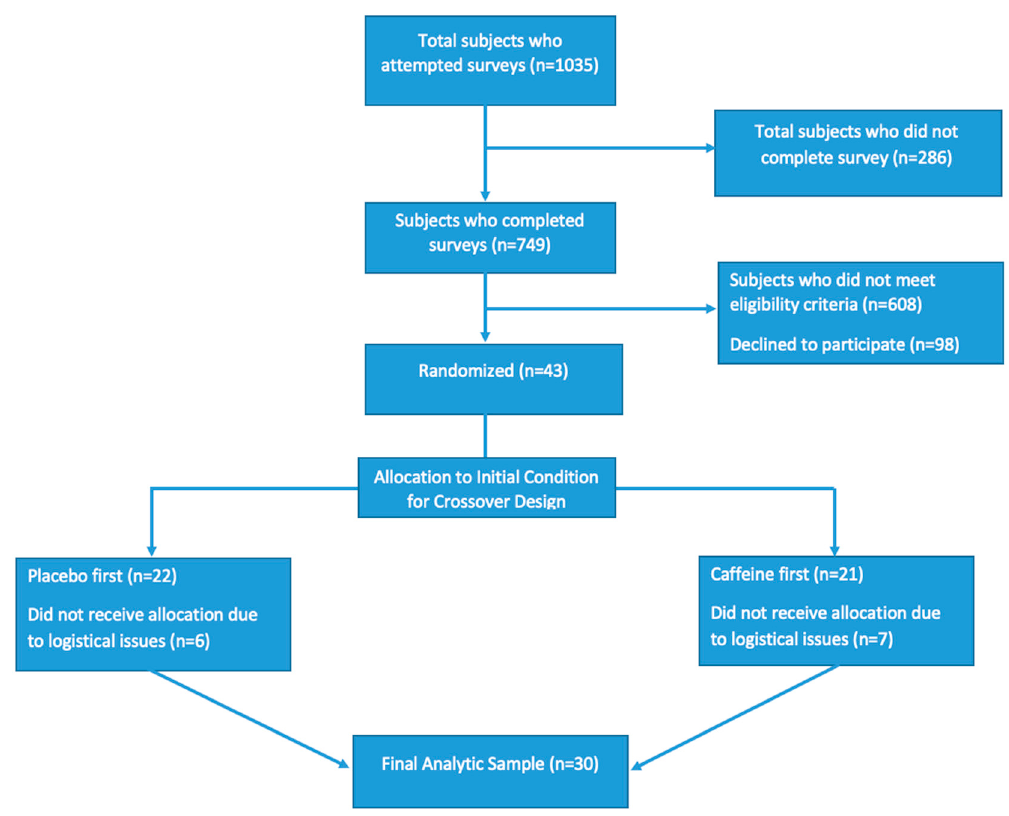
Figure 3. Consolidating Standards of Report Trials (CONSORT) Flow Diagram.